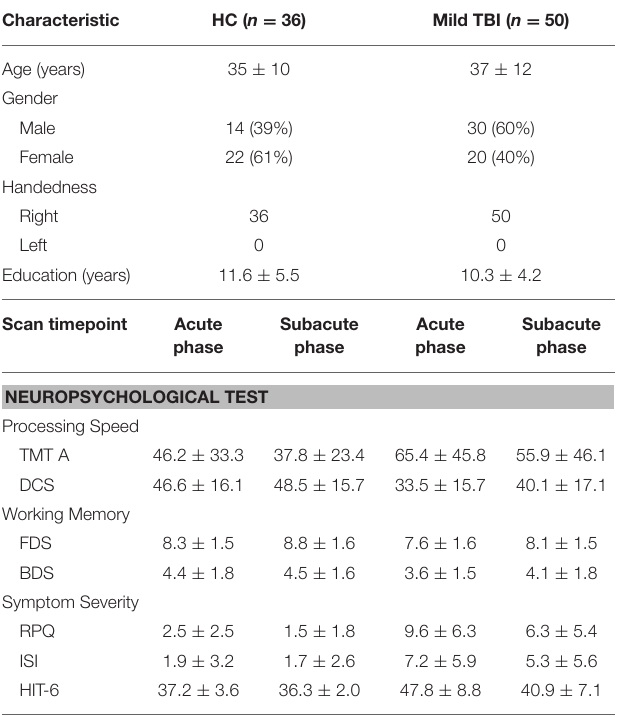
TABLE 2 | Summary of demographic characteristics, neuropsychological test scores between HC and mild TBI